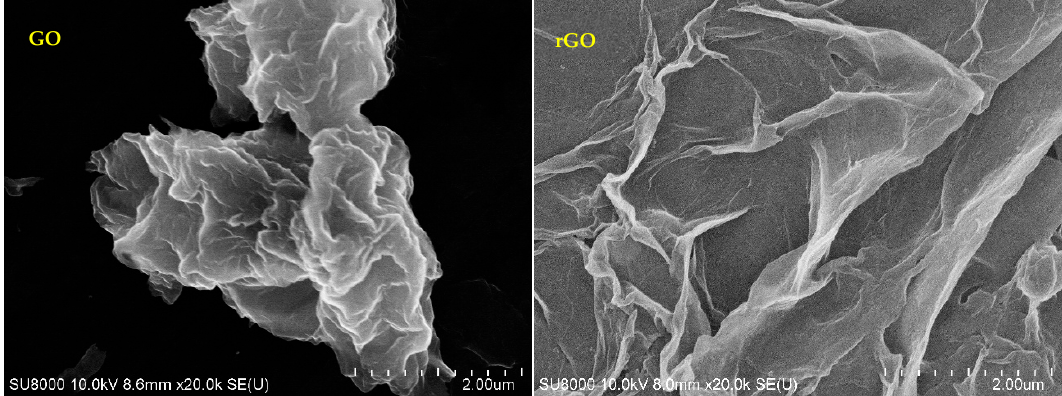
Figure 6. SEM images of GO and rGO synthesized using lemon juice.